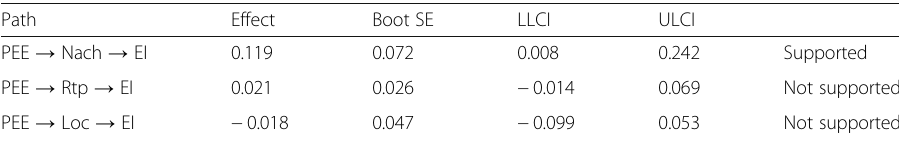
Table 7 Indirect effects of PEE on EI